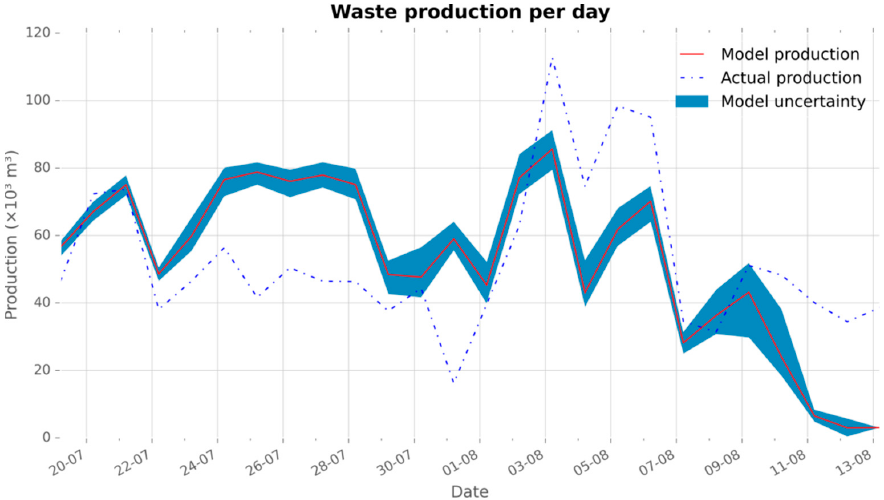
Figure 15. Comparison of daily production of waste, Experiment 2.